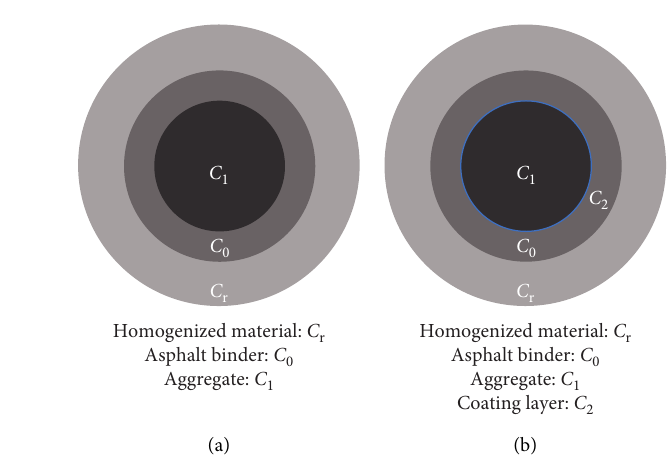
Figure 5: Schematic diagrams of micromechanical models: (a) GSCM and (b) MGSCM.